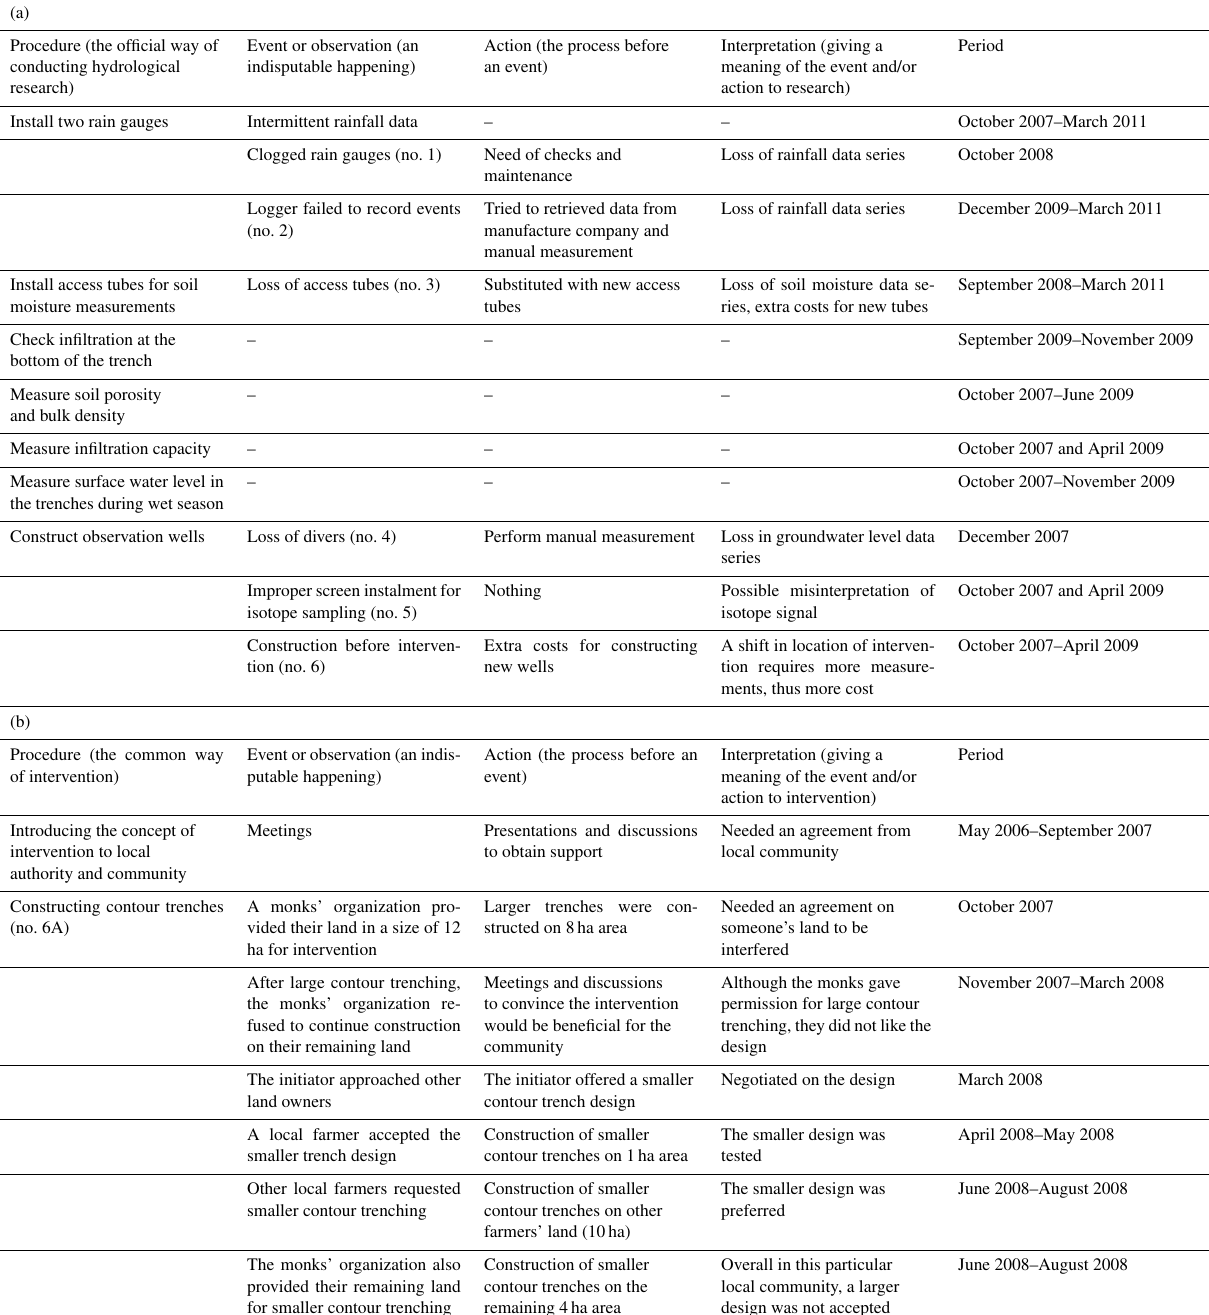
Table 1. (a) Vietnam case: hydrological research; (b) Vietnam case: